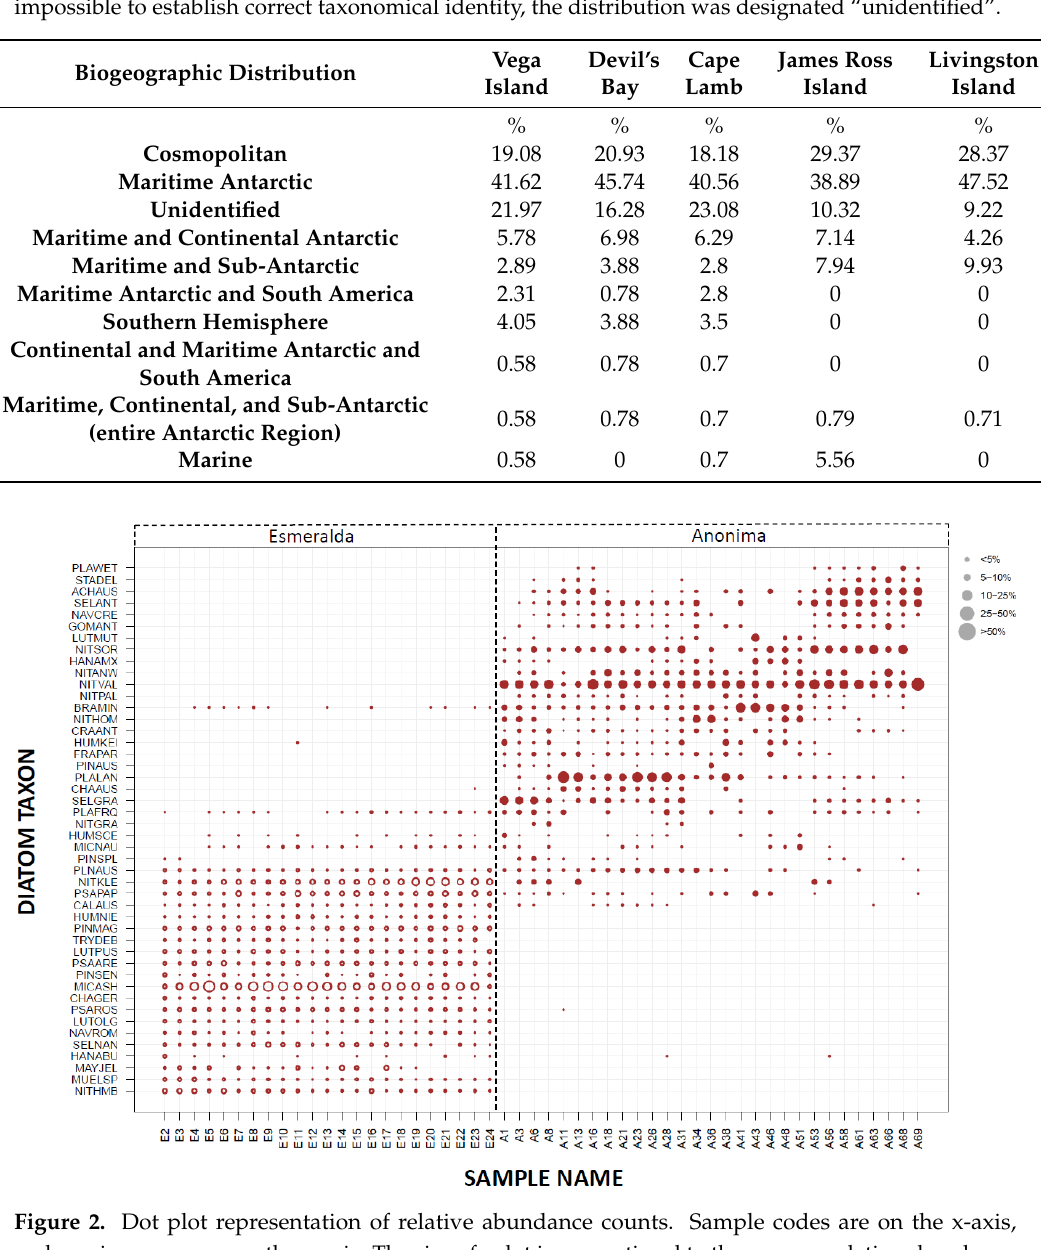
Table 1. Proportion of observed taxa from the entire Vega Island dataset, Devil’s Bay, Cape Lamb, James Ross Island, and Livingston Island exhibiting known biogeographical distributions. When it was impossible to establish correct taxonomical identity, the distribution was designated “unidentified”.